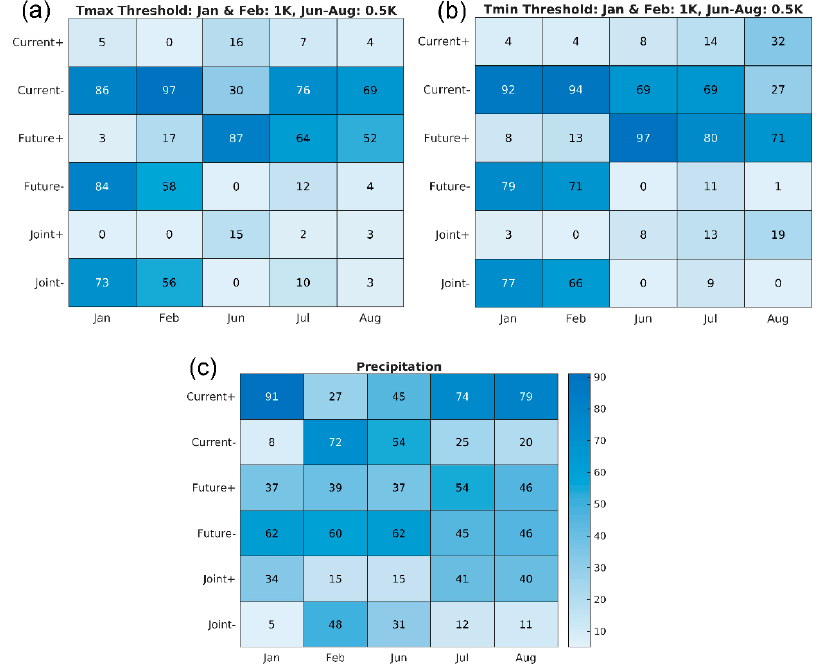
Figure 7. Heatmap showing the percentage of the WRF simulation domain (CONUS land only) that show positive or negative anomalies of the specified magnitude in the HadGEM-WRF historical (current) and future climate simulations, and the joint area in both the HadGEM-WRF current and future climate model output with the same sign of difference, for ( a ) Tmax, ( b ) Tmin, and ( c ) precipitation. Note that in these analyses all differences from HadGEM2-WRF were evaluated at the WRF grid resolution and that thresholds used for the Tmax and Tmin differences were different in summer (±0.5 K) and winter (±1 K).